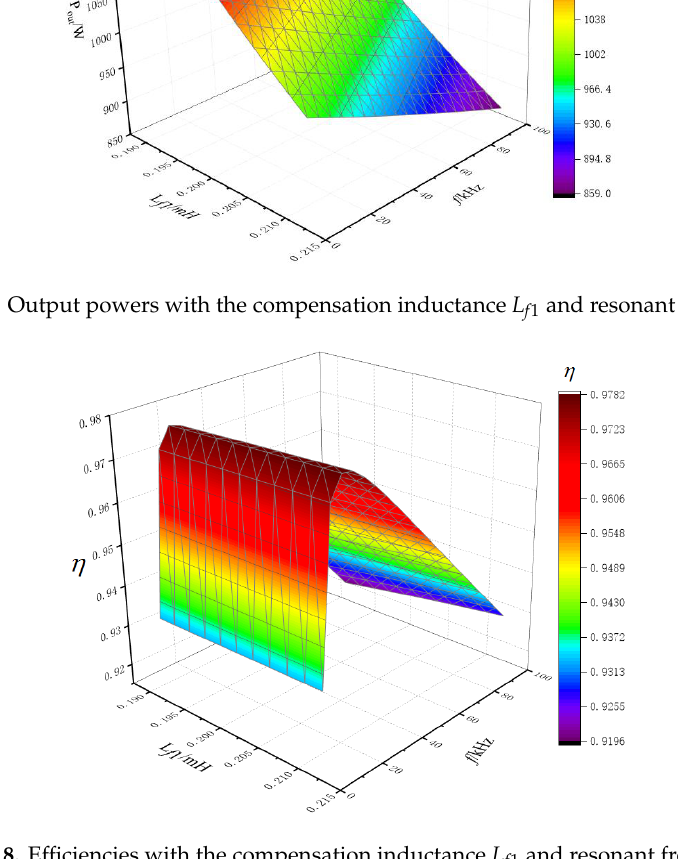
f 1 and resonant